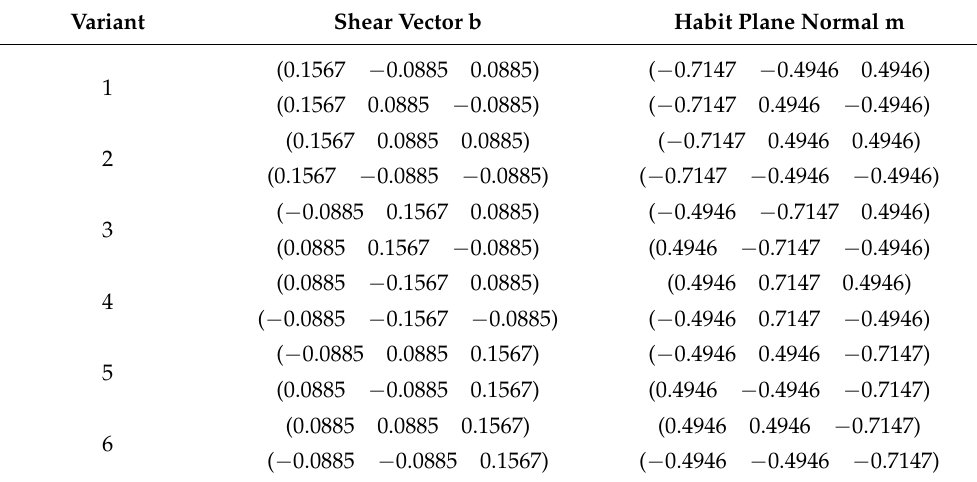
Table 1. Predicted habit plane normal and shear vector from Equation (4) in the parent phase reference